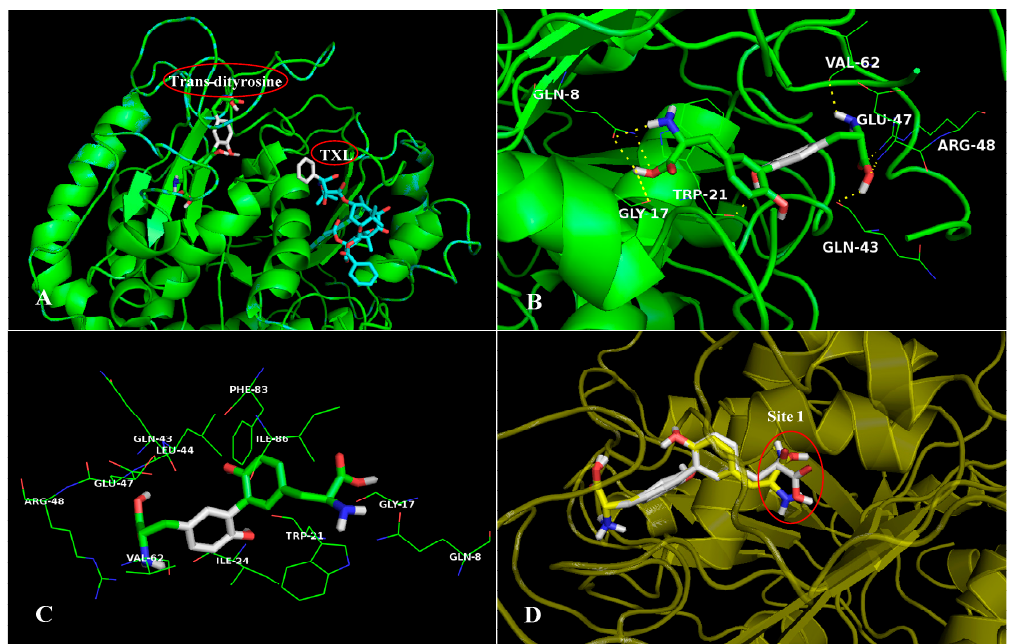
Figure 9. ( A ) Superposition between the crystallographic structures of the complex 1UTB/TXL with the resultant docking pose of 1UTB/TDT. Crystallographic structure and docking structure are represented in blue and green, respectively. ( B ) The enlargement for ligand TDT in the binding site of 1UTB, which is displayed as stick, hydrogen bonds are shown as dotted yellow lines, and the non-polar hydrogens were removed for clarity. ( C ) The active site amino acid residues around TDT. ( D ) Superposition between the resultant docking pose of 1UTB/CDT with the docking pose of 1UTB/TDT, which are represented in white and yellow, respectively.